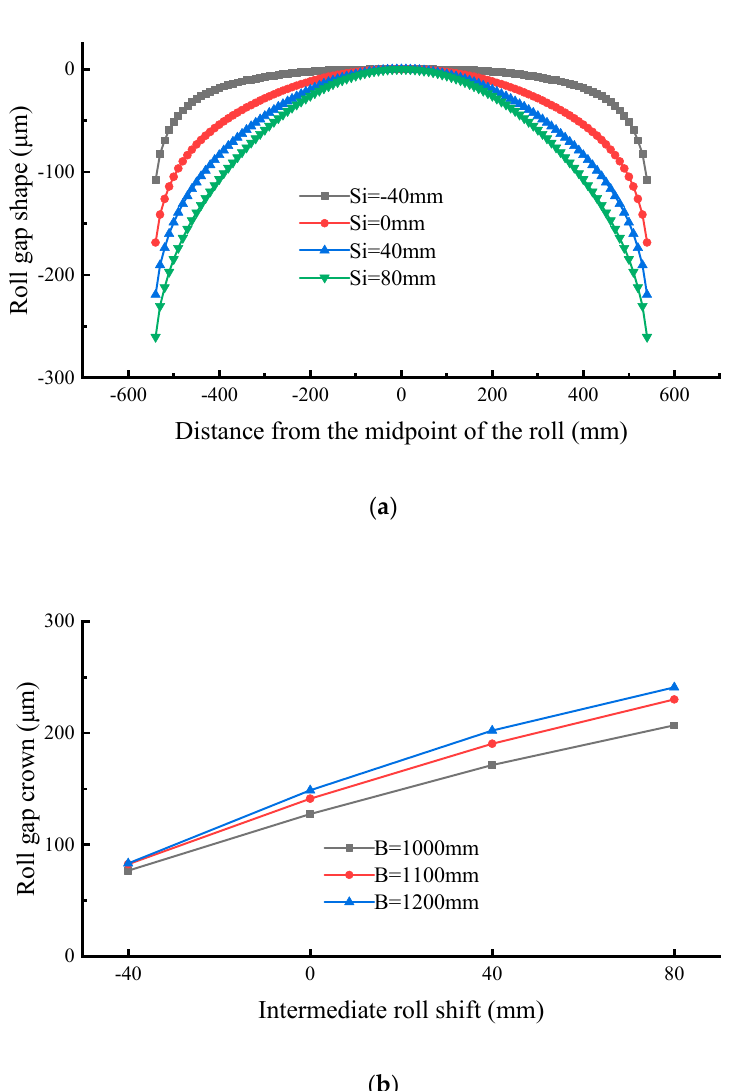
Figure 9. E ff ect of intermediate roll shift on roll gap shape. ( a ) Roll gap shape under di ff erent Figure 9. Effect of intermediate roll shift on roll gap shape. ( a ) Roll gap shape under different intermediate roll shifts, ( b ) e ff ect of intermediate roll shift on roll gap intermediate roll shifts, ( b ) effect of intermediate roll shift on roll gap crown.